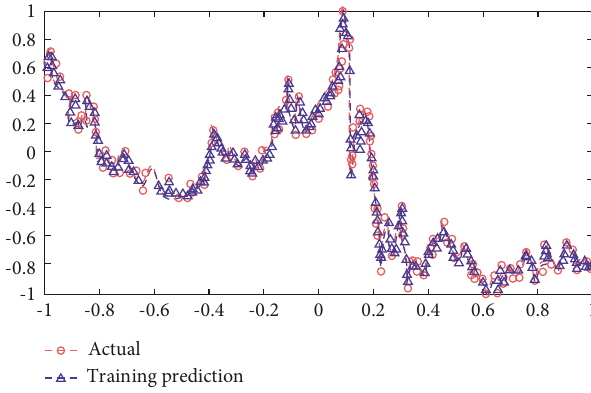
Figure 6: Percentage error of neural network